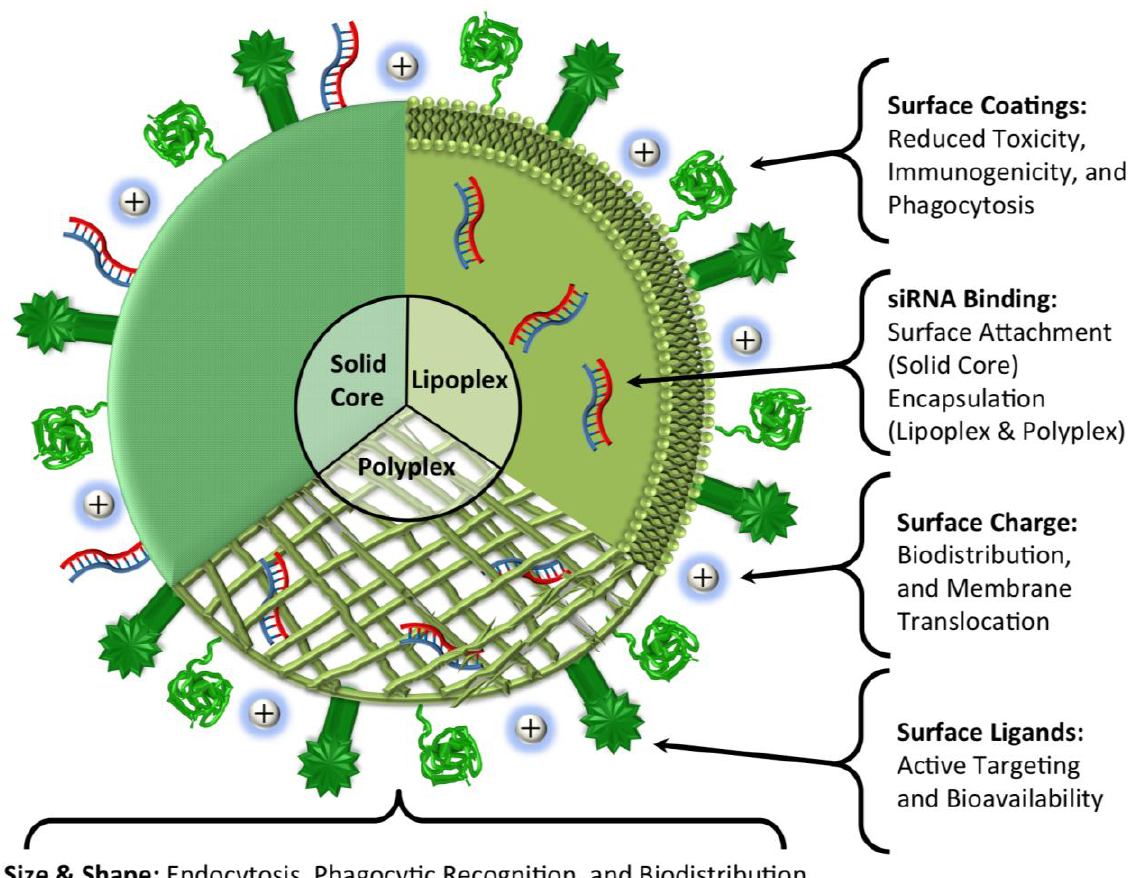
Figure 4. Design characteristics of vehicle-siRNA complexes. A variety of characteristics can be manipulated to improve the bioavailability and biodistribution of vehicle-siRNA complexes while reducing their cytotoxicity and